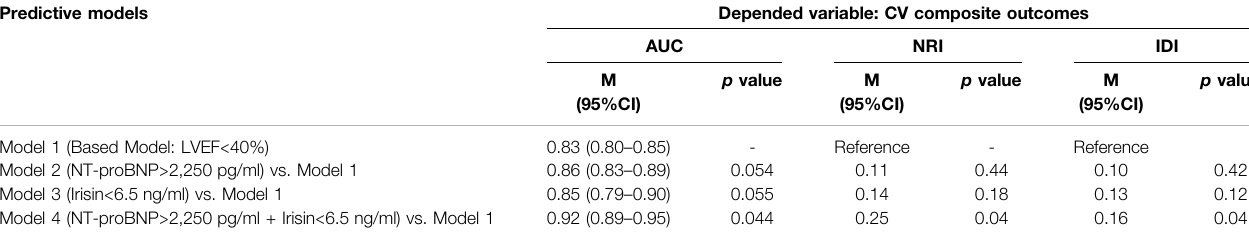
TABLE 4 | Statistics for model fi t for the prediction of CV composite outcomes Predictive models Depended variable: CV composite outcomes